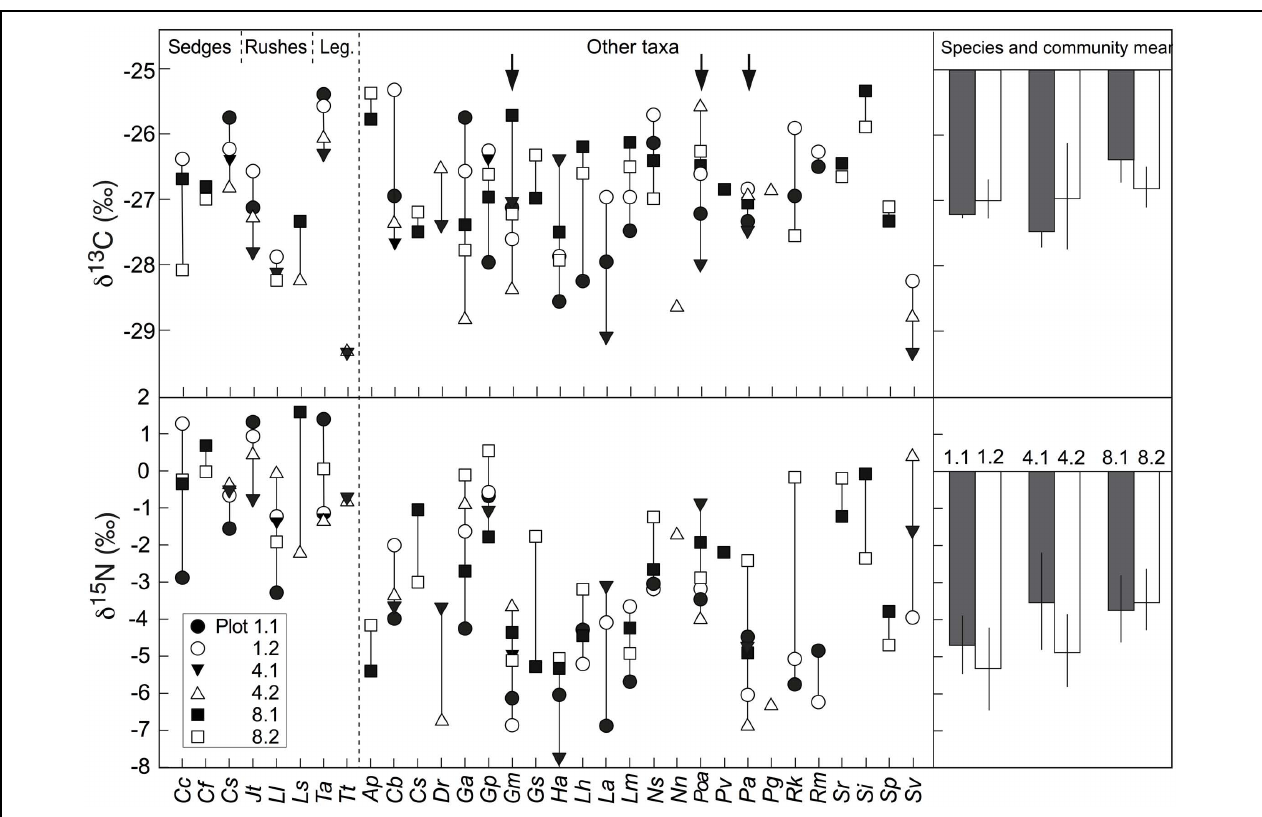
FIGURE 6 | Left: interspecific variation in the natural abundance of δ 13 C and δ 15 N signals in alpine plant species from six different plant communities (five individuals per species and plot). Arrows indicate three species that occurred at all six permanent plots. Sedges include: Cc, Carex curvula ; Cf, Carex foetida and Cs, Carex sempervirens ; Rushes include: Jt, Juncus trifidus ; Ll; Luzula lutea and LS , Luzula sudetica ;